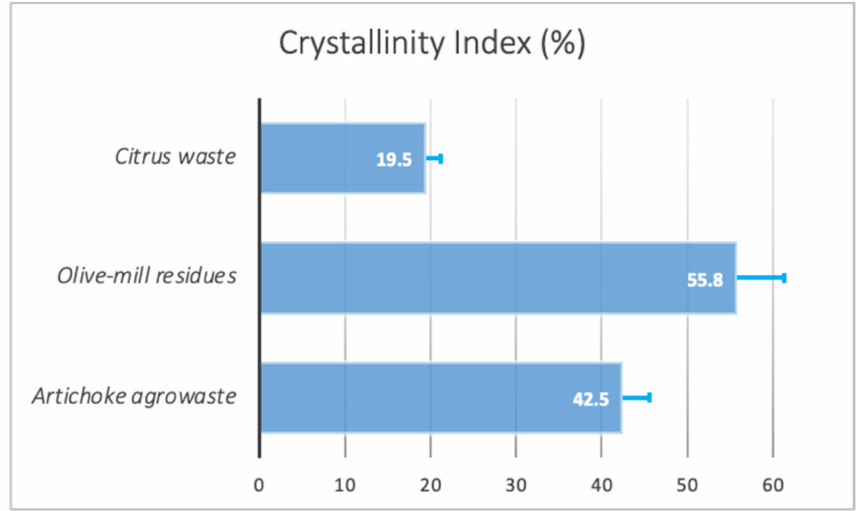
Figure 2. Crystallinity index (mean ± SD of 3 determinations) of the selected agrifood wastes.